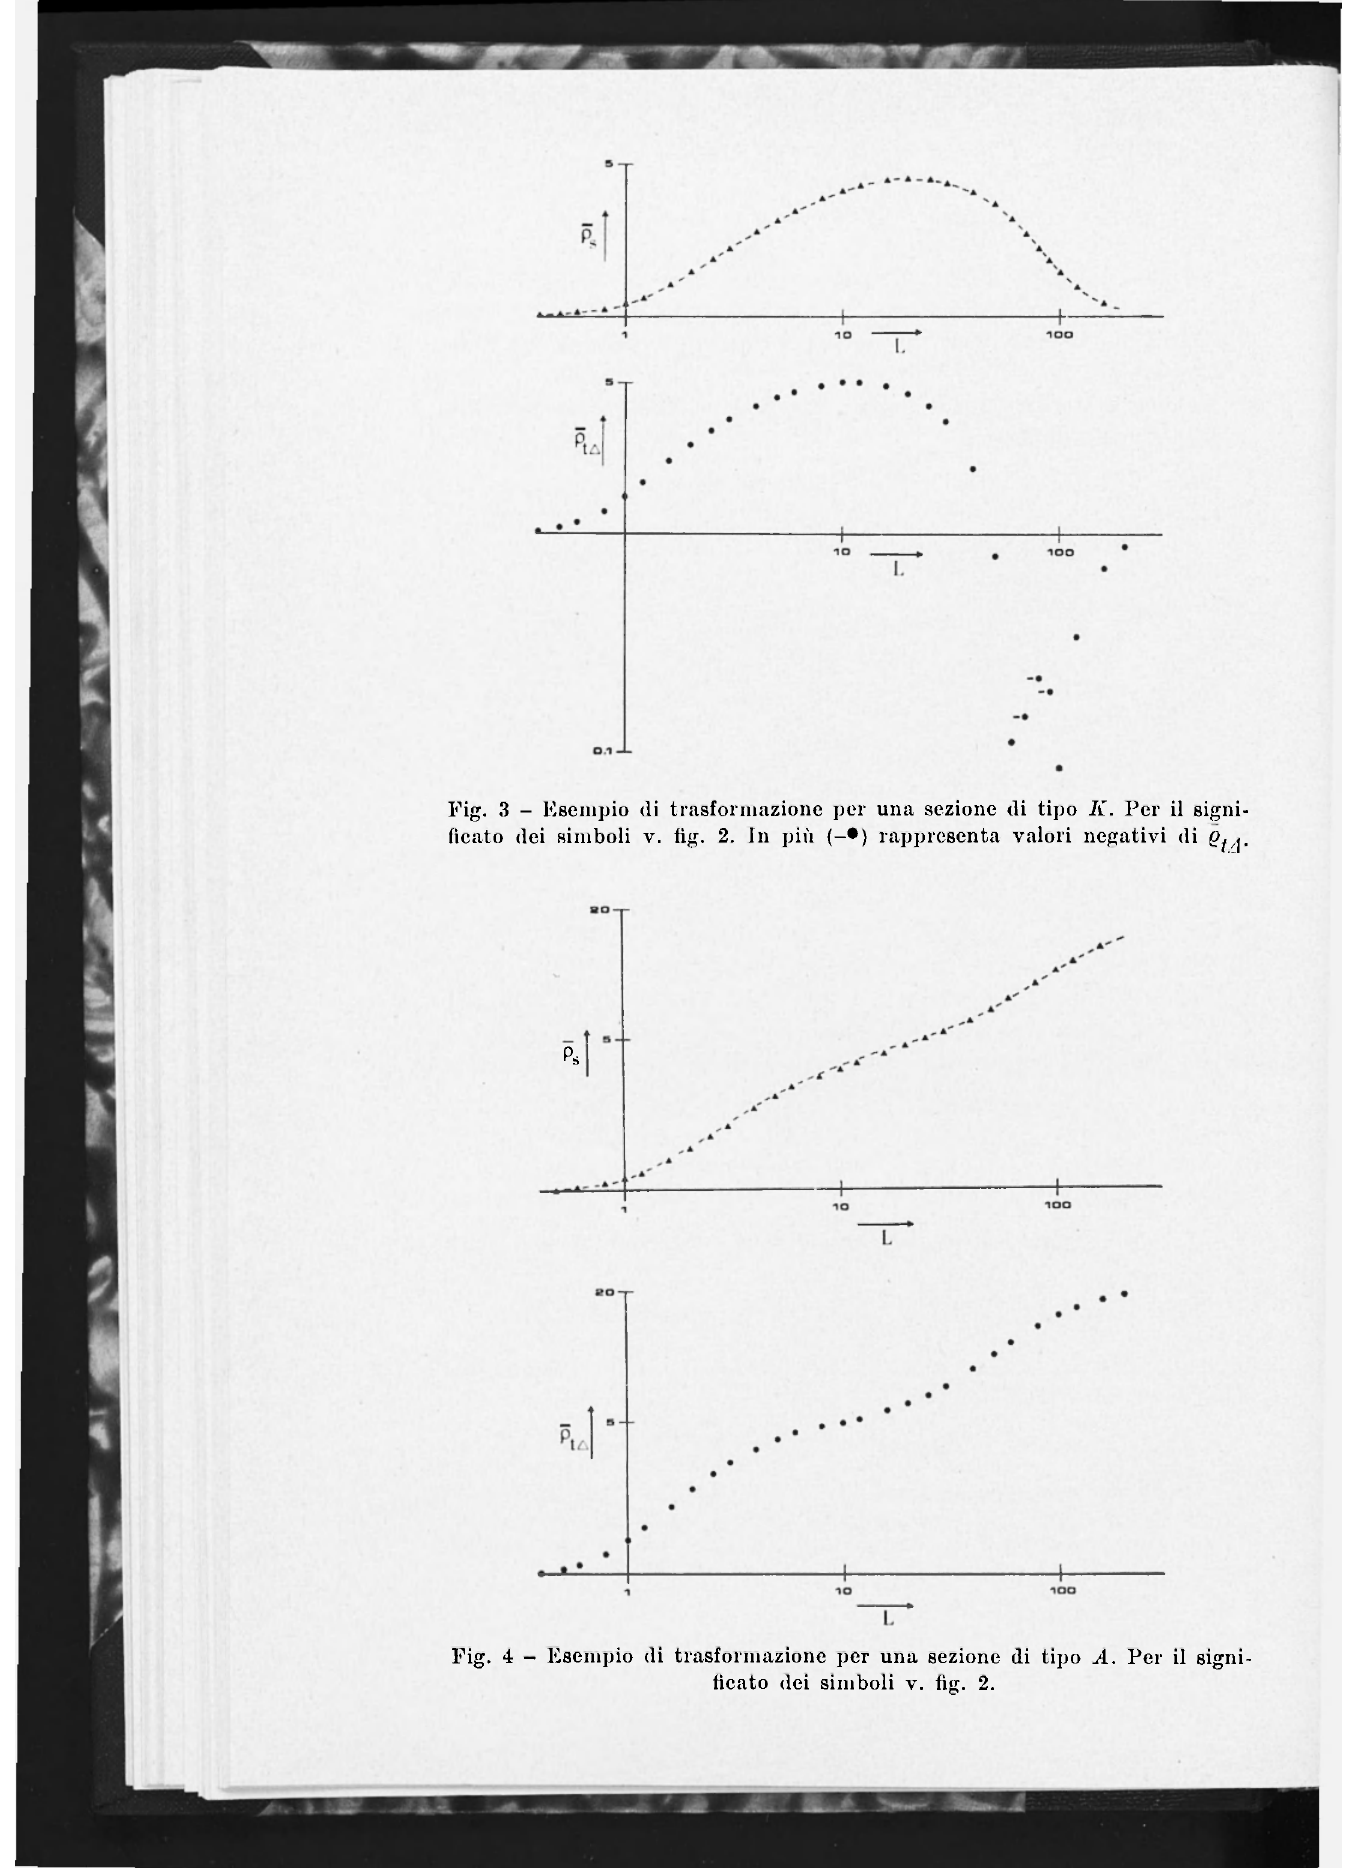
Fig. 4 - Esempio di trasformazione per una sezione di tipo A. Per il signi- ficato dei simboli v. fig.